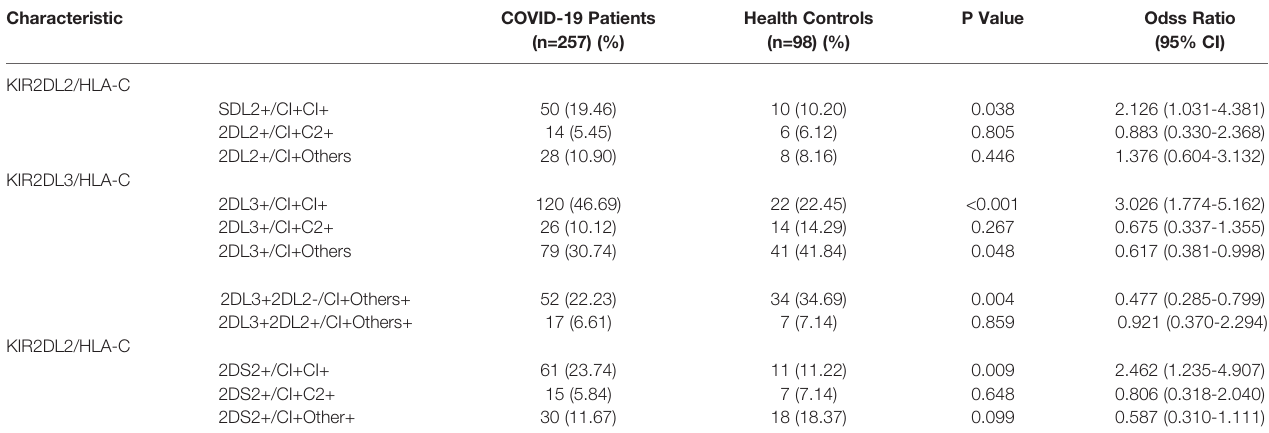
TABLE 2 | Pairing analysis of the frequencies of KIR2DL2/2DL3/2DS2 and HLA-C in COVID-19 patients and healthy persons. Characteristic COVID-19